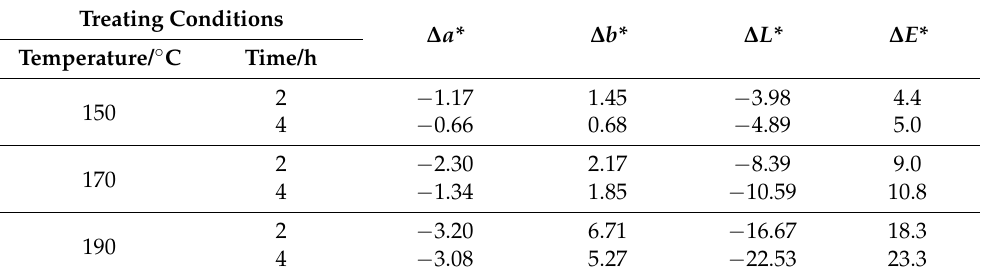
Table 2. Effect of Heat Treatment on Wood